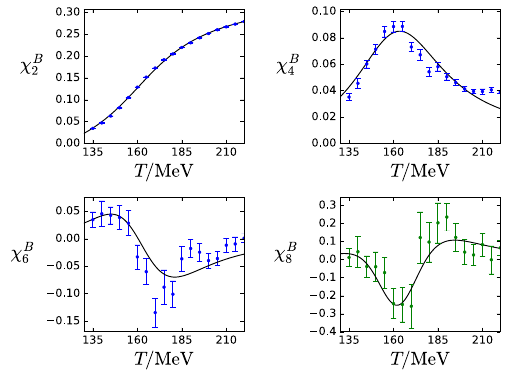
, χ B , χ B and an estimate for χ B on a N t = 12 lattice as functions of the 2 4 8 6 in green to point 8 . The black curve in each panel 4